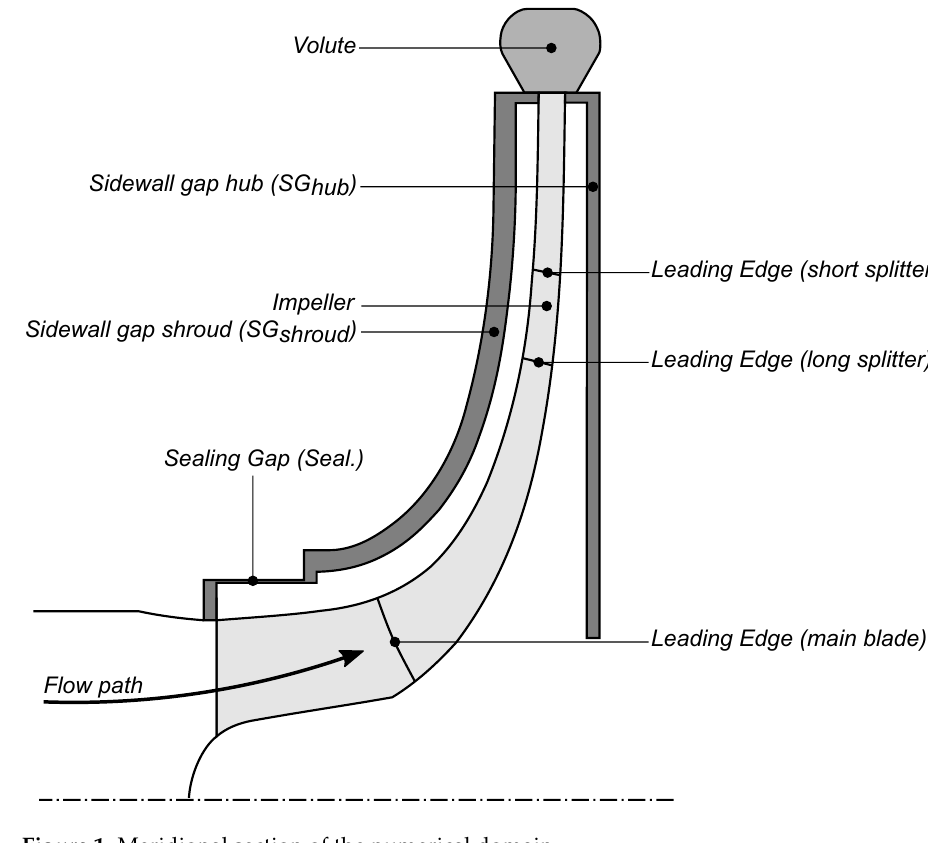
Figure 1. Meridional section of the numerical domain.